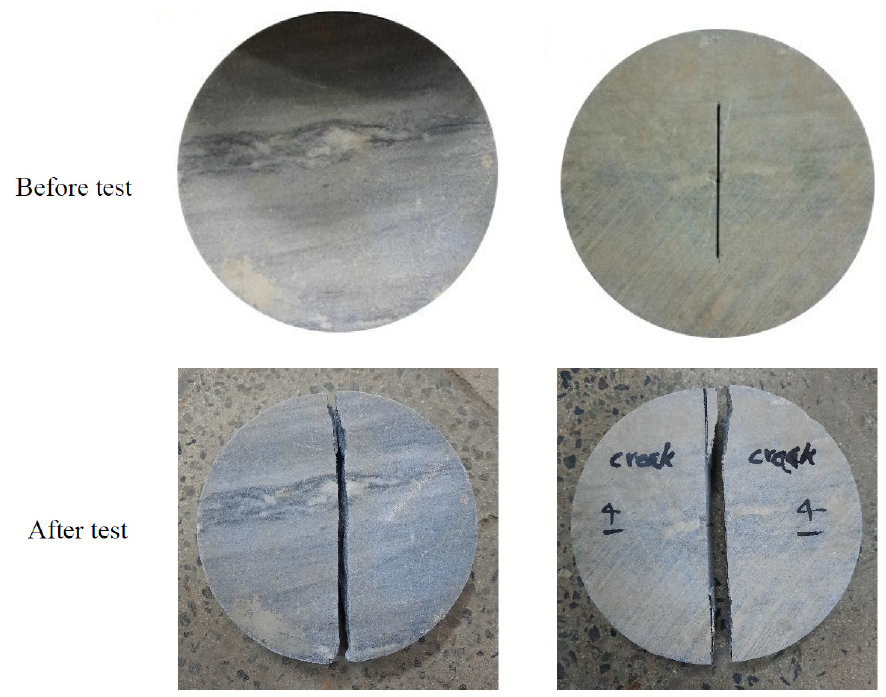
Figure 4. BD ( left ) and CBD ( right ) samples tested to determine the tensile strength and the fracture toughness, before and after being tested.